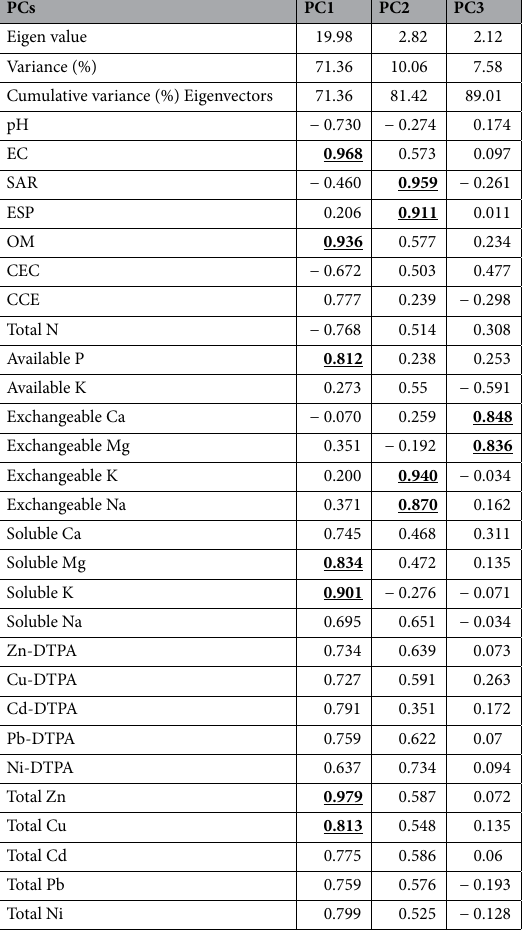
Table 4. Data of principal component analysis (PCA) for soil quality variables. TDS: total data set; MDS: minimum data set; OM: organic matter; CCE: calcium carbonate equivalent; CEC: cation exchange capacity; EC: electrical conductivity; SAR: sodium adsorption ratio; ESP: exchangeable sodium percentage. Underlined bold font values are considered highly